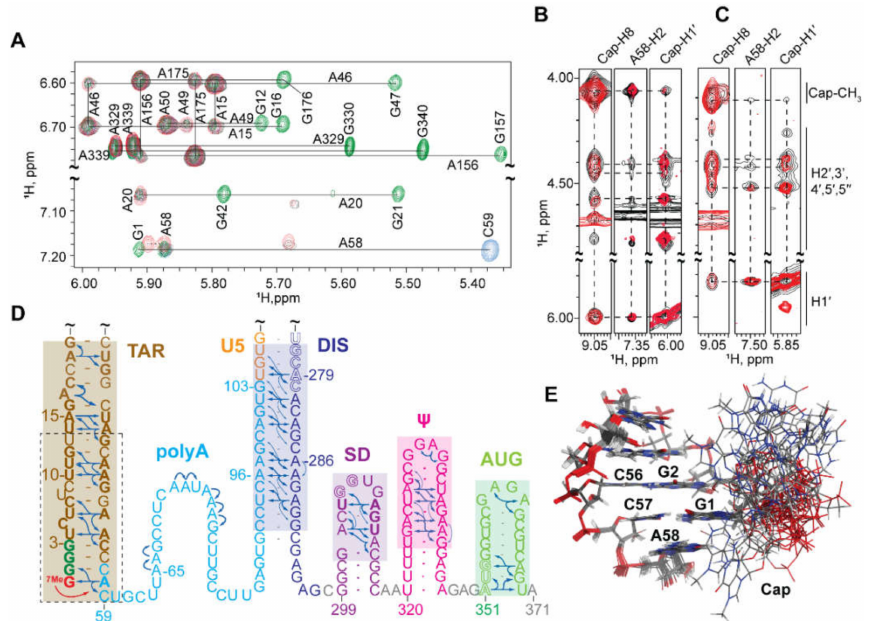
Figure 11. NMR and structural findings for the monomeric Cap 3G and Cap 2G forms of the HIV-1 MAL leader. ( A ) Regions of the 2D 1 H- 1 H NOESY spectra for the non-capped 3G- leader 371 (A H , black; A 2r G r , green; A 2r C r , blue; G1 H A 2r , red) used to make secondary structure assignments shown in D. ( B ) Overlapped 2D 1 H- 1 H NOESY spectra for A 2 - Cap 2G-leader 371 (black) and TAR